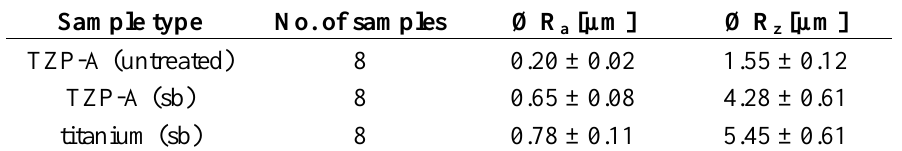
Table 3. Roughness parameters for reference samples (TZP-A and titanium).